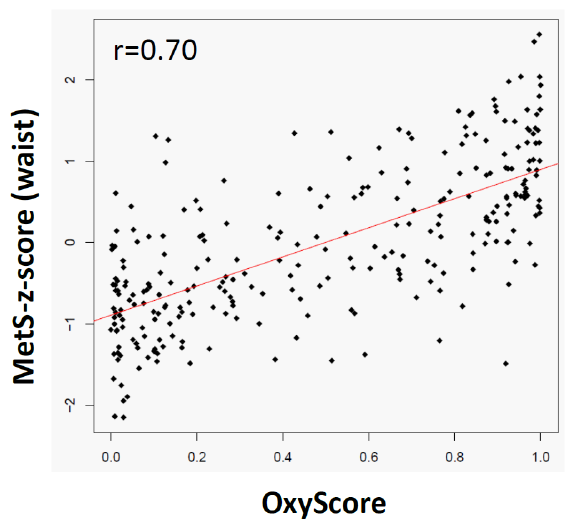
Figure 6. Relationships between the OxyScore and the Met-z-score. The OxyScore (i.e., probability of having MetS according to the identified and validated oxylipin signature, see Table S2) was computed for all participants in the Discovery cross-sectional study. Spearman correlation was established between the computed OxyScore and the Met-z-score. The Spearman correlation coefficient (r) was highly significant ( p < 0.001). The red line represents the linear orientation of the relation.